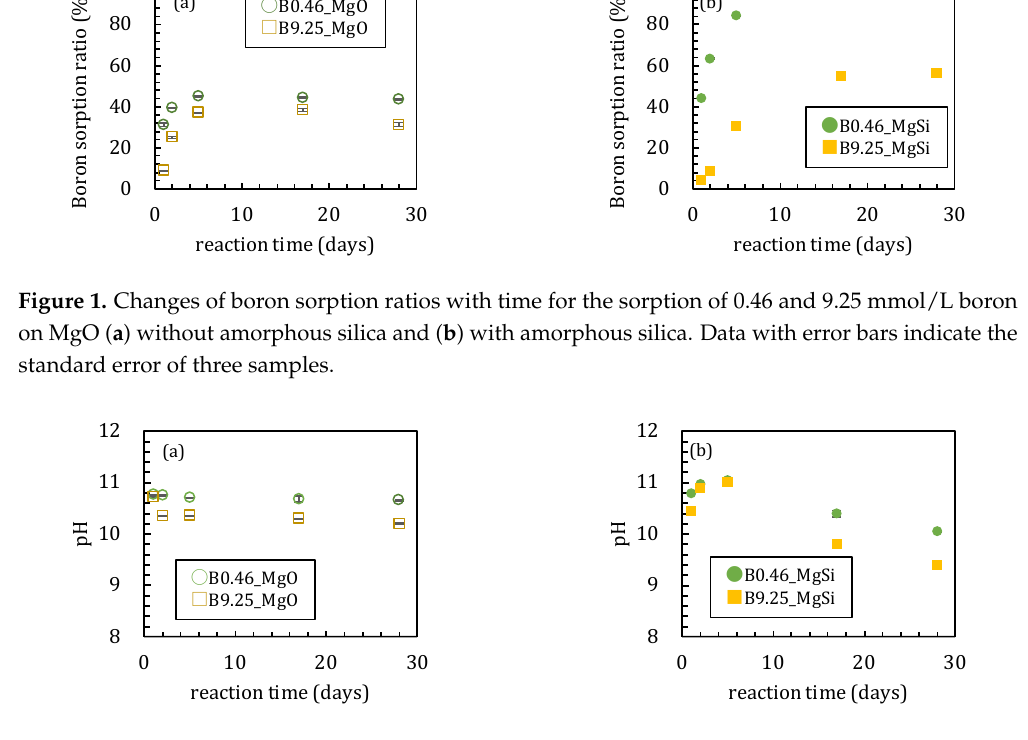
Figure 2. Changes in pH during sorption for ( a ) without amorphous silica and ( b ) with amorphous silica. Data with error bars indicate the standard error of three samples.